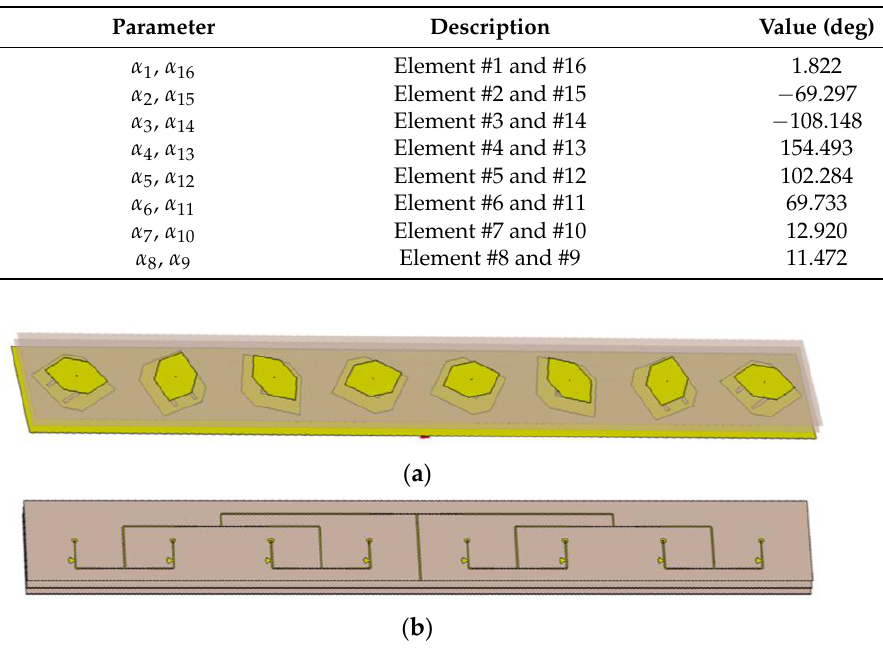
Figure 11. Design 1 – 8-element patch array: simulated gain at 1.275 GHz. Figure 12. Design 1 – 8-element patch array: simulated gain at 1.575 GHz. ( a ) ( b )